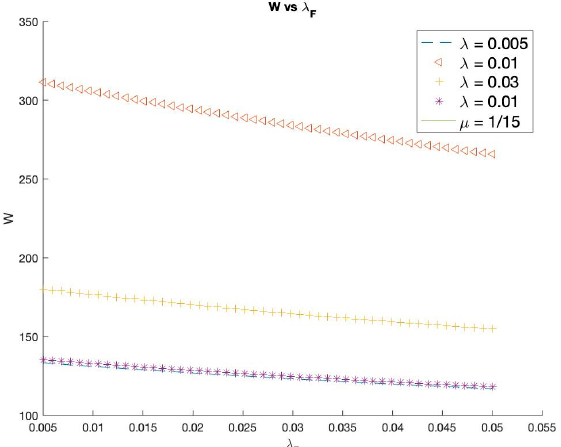
Figure 13. Average amount of time in system ( (cid:1849) ) vs rate of unsuccessful arrival ( λ (cid:3007) ). The following graph plots (cid:1849) (cid:3018) versus λ (cid:3007) , for various λ , a (cid:2020) (at 1/15), and (cid:1866) (at 10).